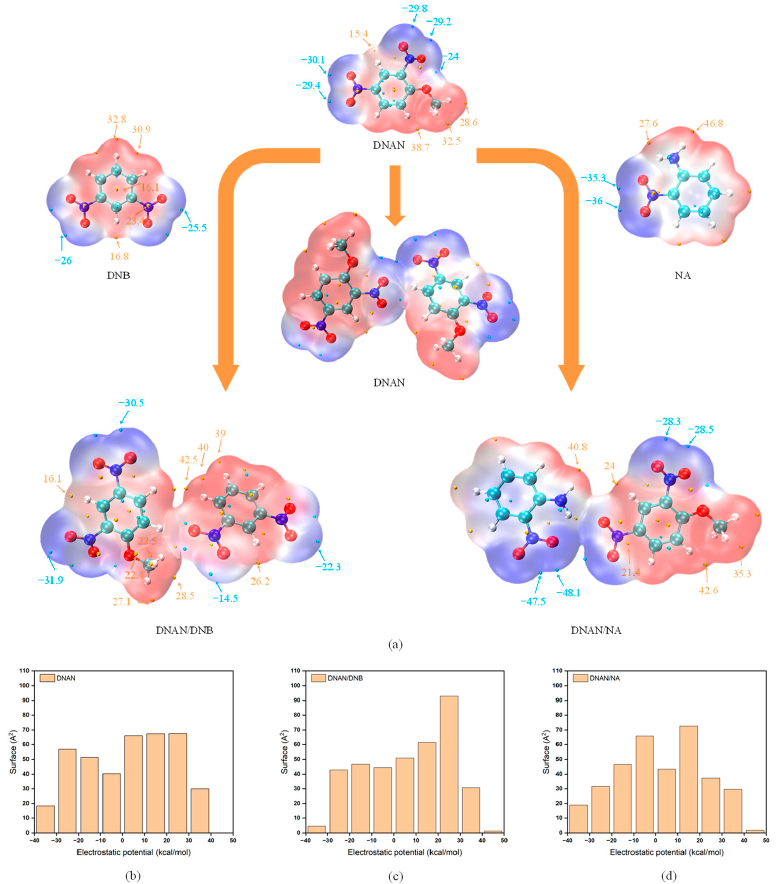
Figure 5. ESP in different clusters from pure DNAN, DNAN/DNB, and DNAN/NA ( a ), and surface −− area distribution of ESP of pure DNAN ( b ), DNAN/DNB ( c ), and DNAN/NA ( d ).